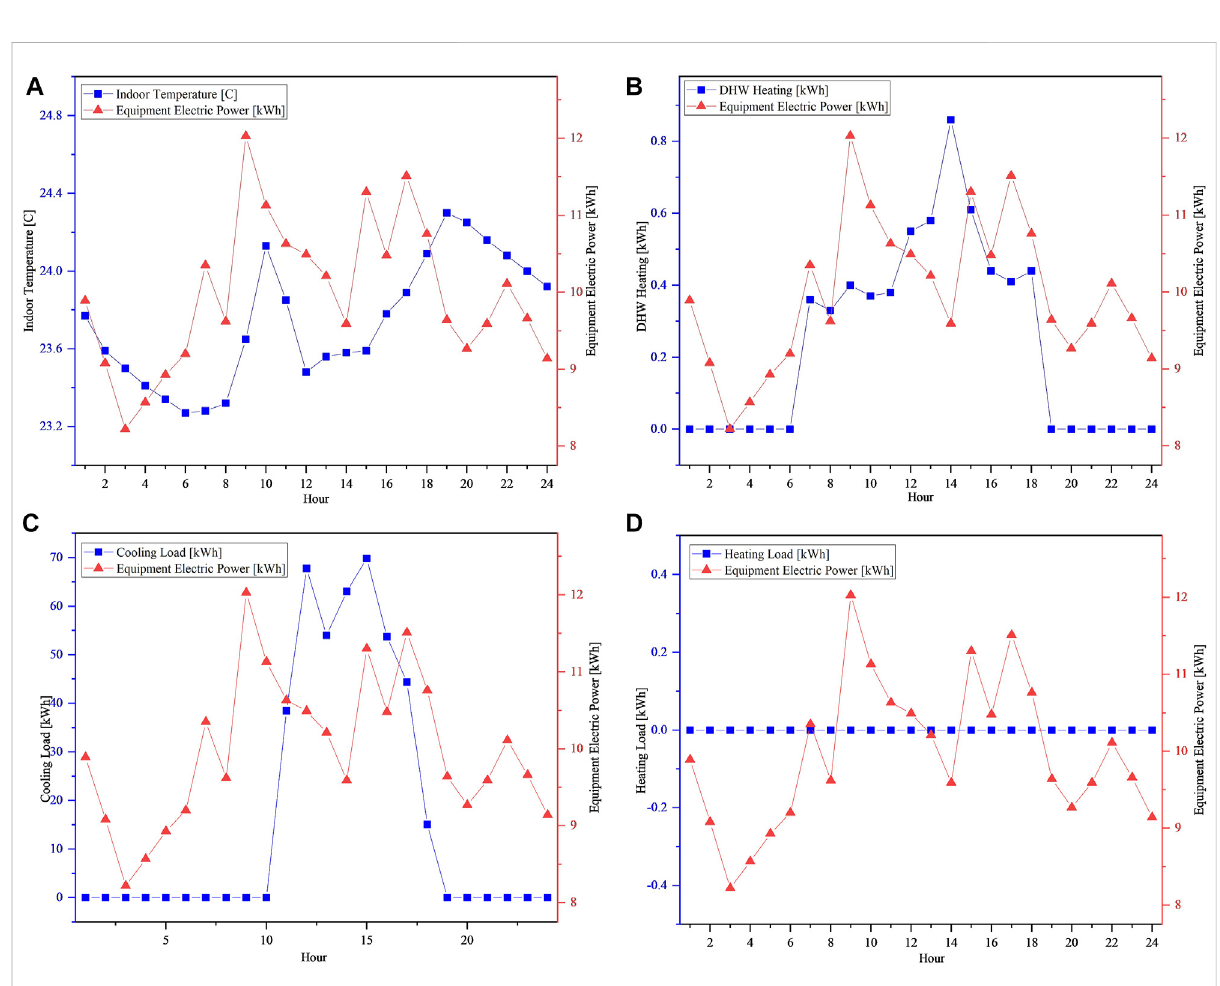
FIGURE 4 The temporalrelationship between power load and four key variables. (A) Indoor temperature; (B) DHW Heating; (C) Cooling Load; (D) Heating